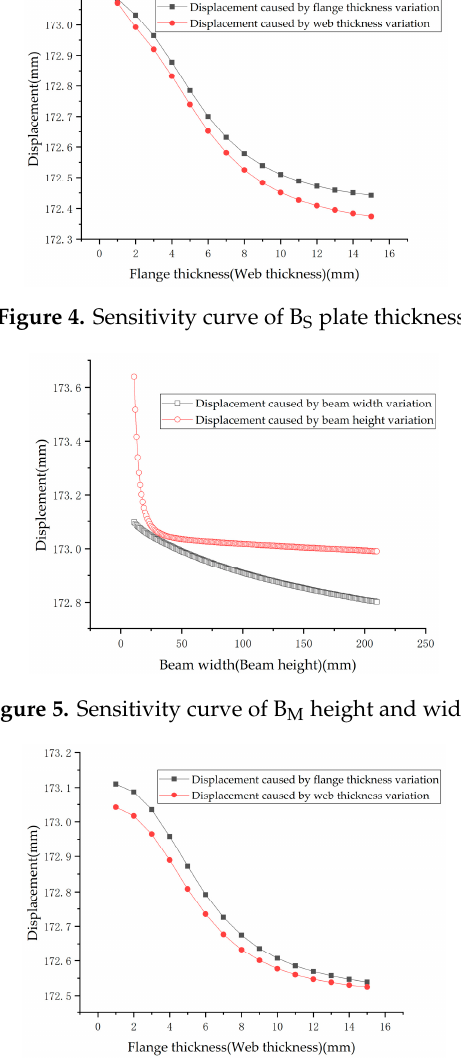
Figure 7. Sensitivity curve of C C height and width.